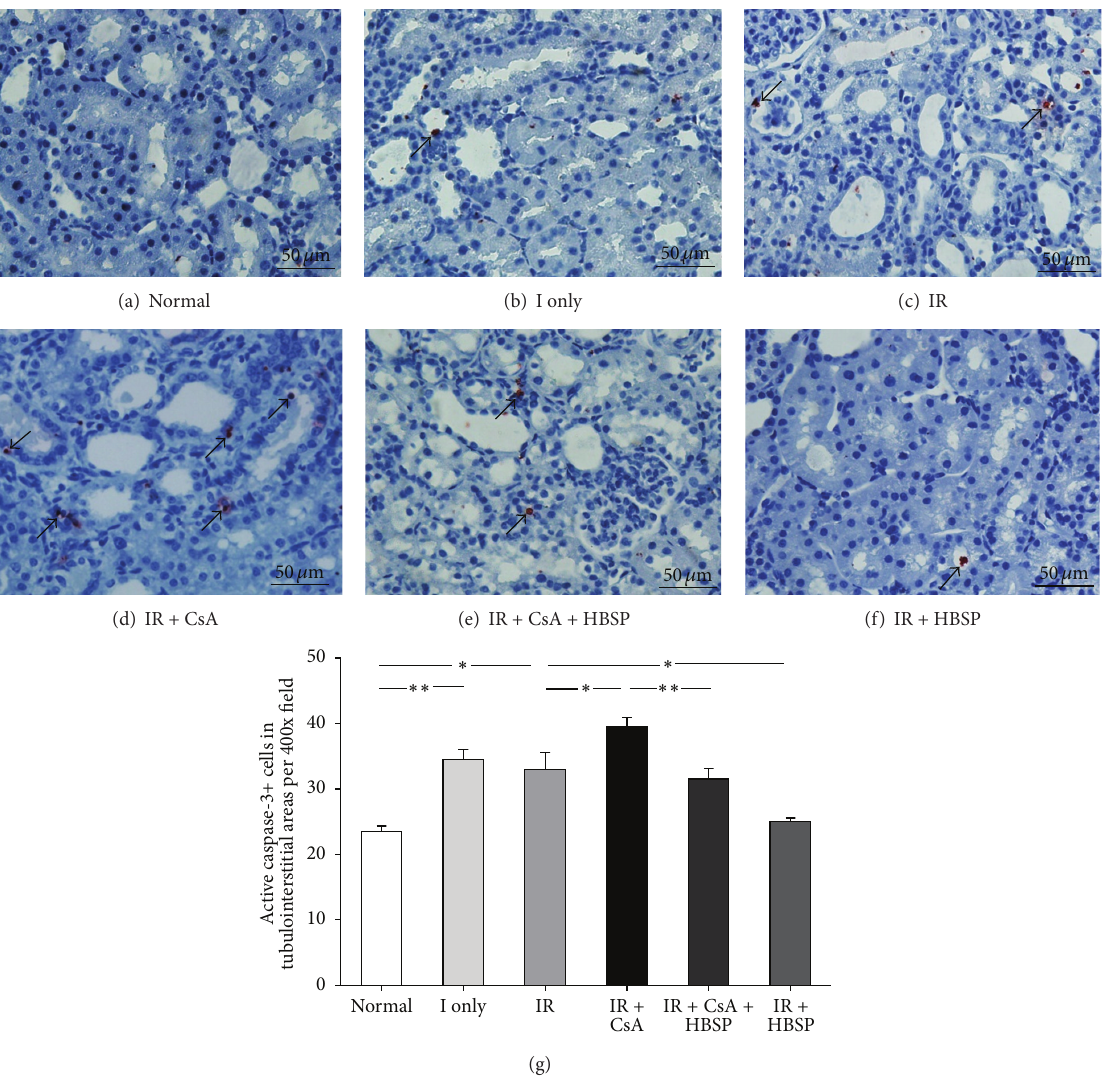
Figure 6: The majority of active caspase-3+ cells, detected by immunostaining (a–f), were demonstrated morphologic features of apoptosis such as condensed nuclei. HBSP significantly decreased active caspase-3+ cells in both the IR kidneys and IR + CsA kidneys (g). Data are expressed as mean number per high power field of each group (mean ± SEM; 𝑛 = 6 ). ∗ 𝑃 < 0.05 ; ∗∗ 𝑃 < 0.01